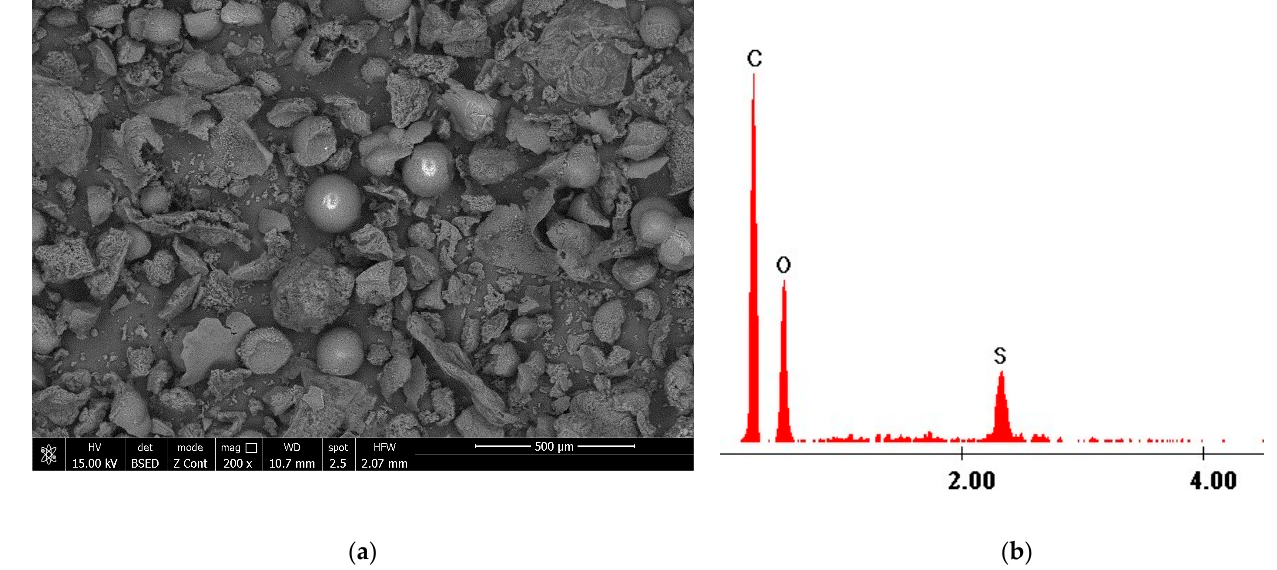
Figure 2. Scanning electron microscopy, SEM, and energy dispersive X-ray, EDX, for coP-TEDMA/EGDMA. ( a ) SEM migrography; ( b ) EDX spectra.